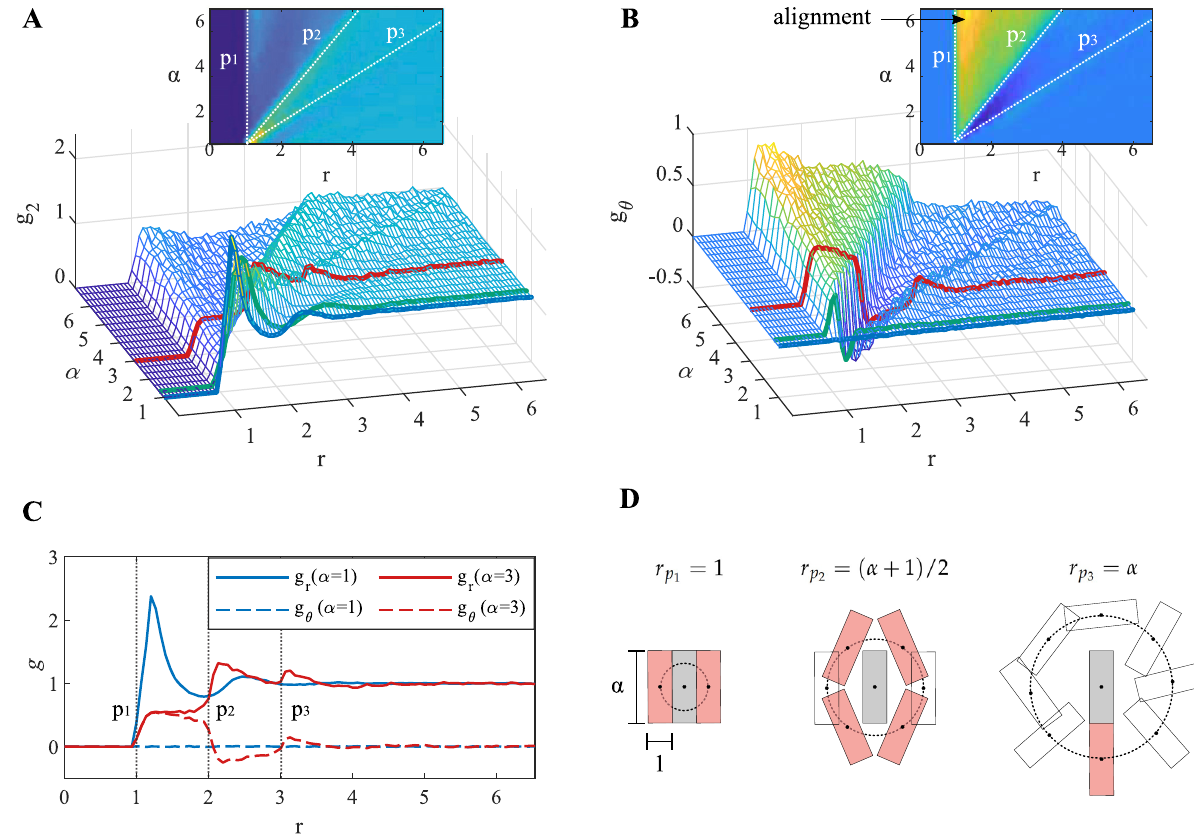
Figure 2: Point process analysis of maximally random packed rectangles: (A) radial pair correlation functions g 2 ( r , α ) given by Eq. (2) and (B) orientational correlation function g θ ( r , α ) given by Eq. (3). Three different aspect ratios are highlighted on both surfaces with different colors; the blue line corresponds to α (cid:2) 1, green to α (cid:2) 1 . 3, and red to α (cid:2) 3. The insetsonboth surfacescorrespondtoa topviewperspective withthreeimportantfeatureshighlightedby p 1 , p 2 , p 3 lines.(C) Acrosssectional plotof g 2 and g θ surfacesat α (cid:2) 1and α (cid:2) 3and(D)geometricalillustrationoftheoriginof p 1 , p 2 , p 3 lines,respectively.Foreachcon fi guration, the dashed circle with radius r pi represents the shortest distance between rectangles ’ center for overlap to be